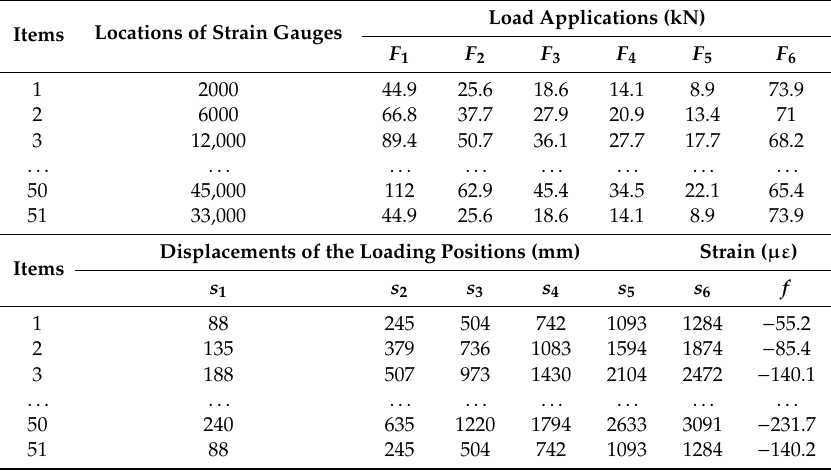
Table 5. The training samples used by BPNN and PSO-BPNN